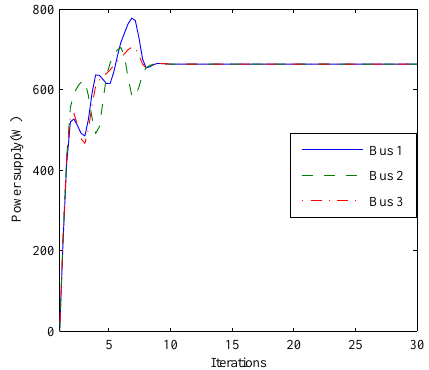
Figure 9. The convergence of the power